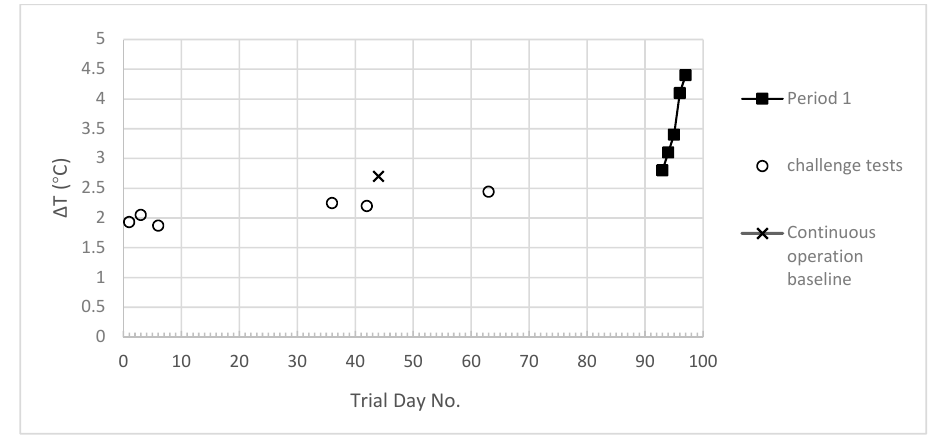
Figure 5. Temperature di ff erence between untreated wastewater and treated wastewater